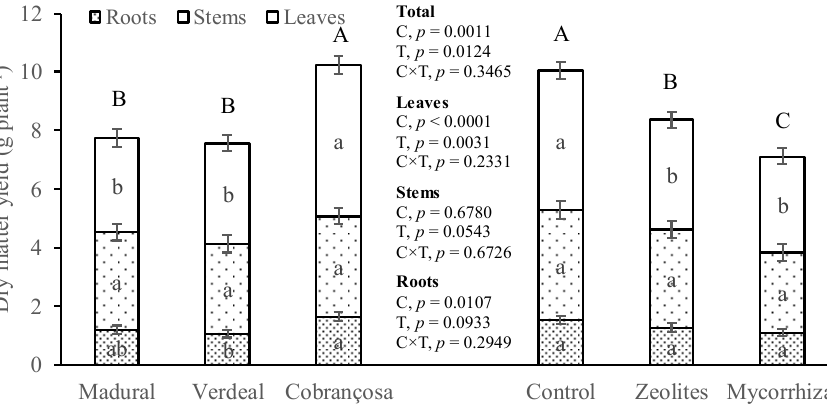
Figure 1. Dry matter yield of young plants separated by roots, stems, and leaves in the factorial design of cultivars (C) × soil treatments (T). After ANOVA examination ( p, Prob. > F ) , to each experimental factor (cultivars or soil treatments), and within each plant part (lowercase letters), and total (uppercase letters) means ( n = 6) followed by the same letter are not significantly different by Tukey HSD test ( α = 0.05). Vertical bars are the standard errors.